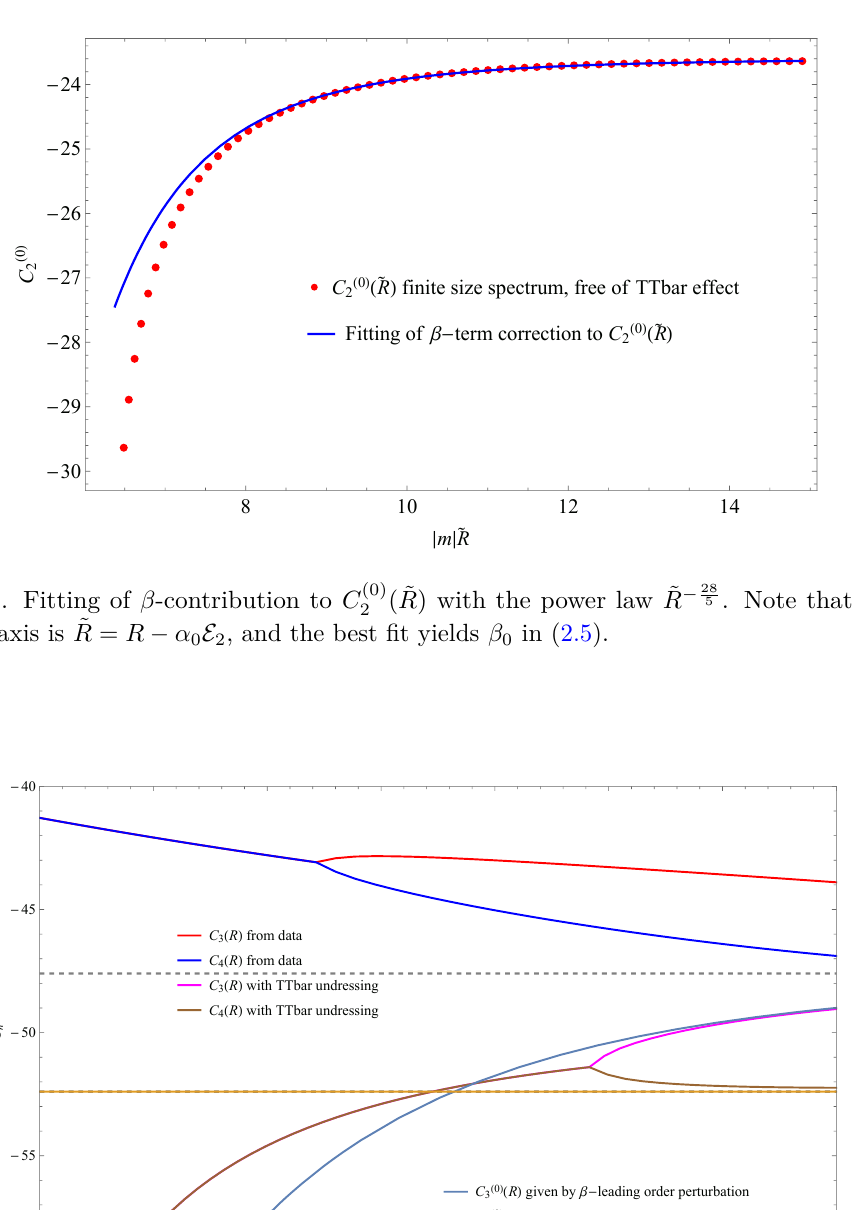
Figure 11 . “Level crossing” of C 3 ( R ) and C 4 ( R ) . TFFSA data for C 3 ( R ) and C 4 ( R ) are shown in red and blue, respectively. The real parts are shown below the crossing point at R ≈ 12 . 4 , where the levels turn into a complex conjugate pair. The dotted lines show the constant C 3 and C 4 from eq. (3.9). The “TTbar-undressed” functions C (0) respectively. Light blue and light brown represent approximation (3.14) for C (0)